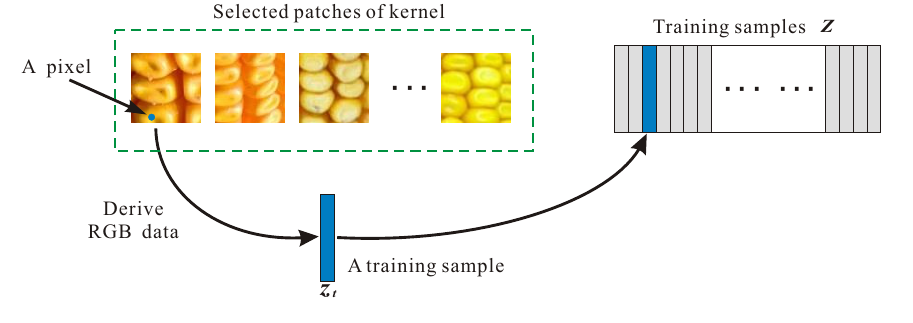
Figure 3. Graphical representation for the generation of training samples.